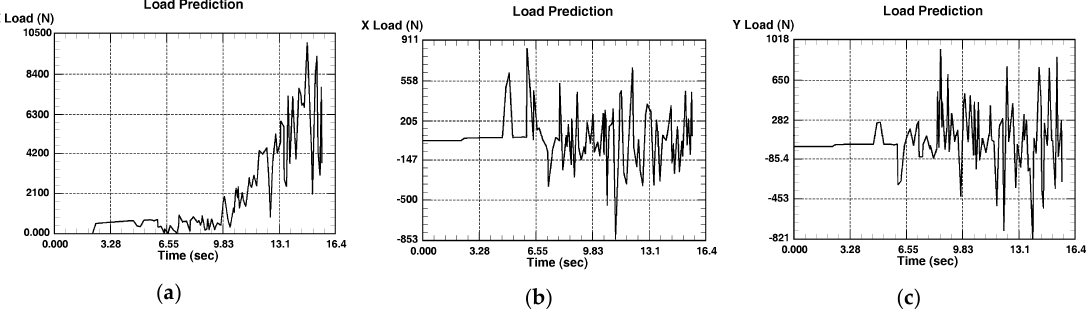
Figure 9. The forces obtained by numerical simulation in the first stage of the process for the 34th point of the experimental plan: ( a ) Axial force F z ; ( b ) longitudinal force F x ; ( c ) side force F y .